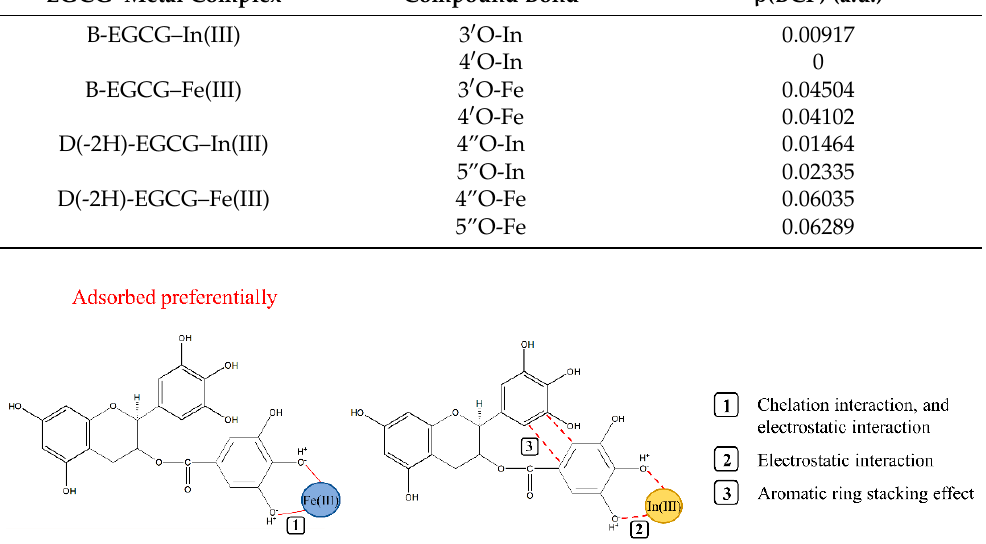
Figure 4. Diagram of the possible interaction mechanism between the deprotonated EGCG and Fe(III)/In(III).